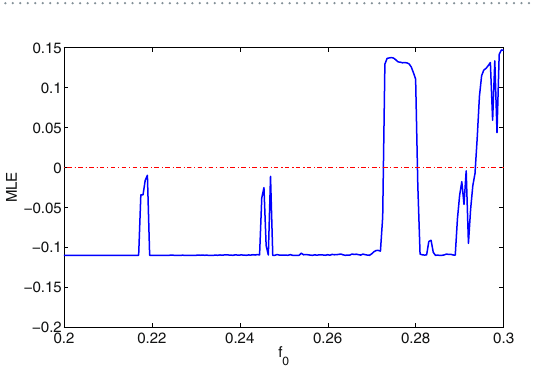
Figure 5. Bifurcation diagram of mechanical displacement q with varying f 0 in ( a ) and bifurcation diagram of real part of optical state a with same range of varying f 0 in ( b ).